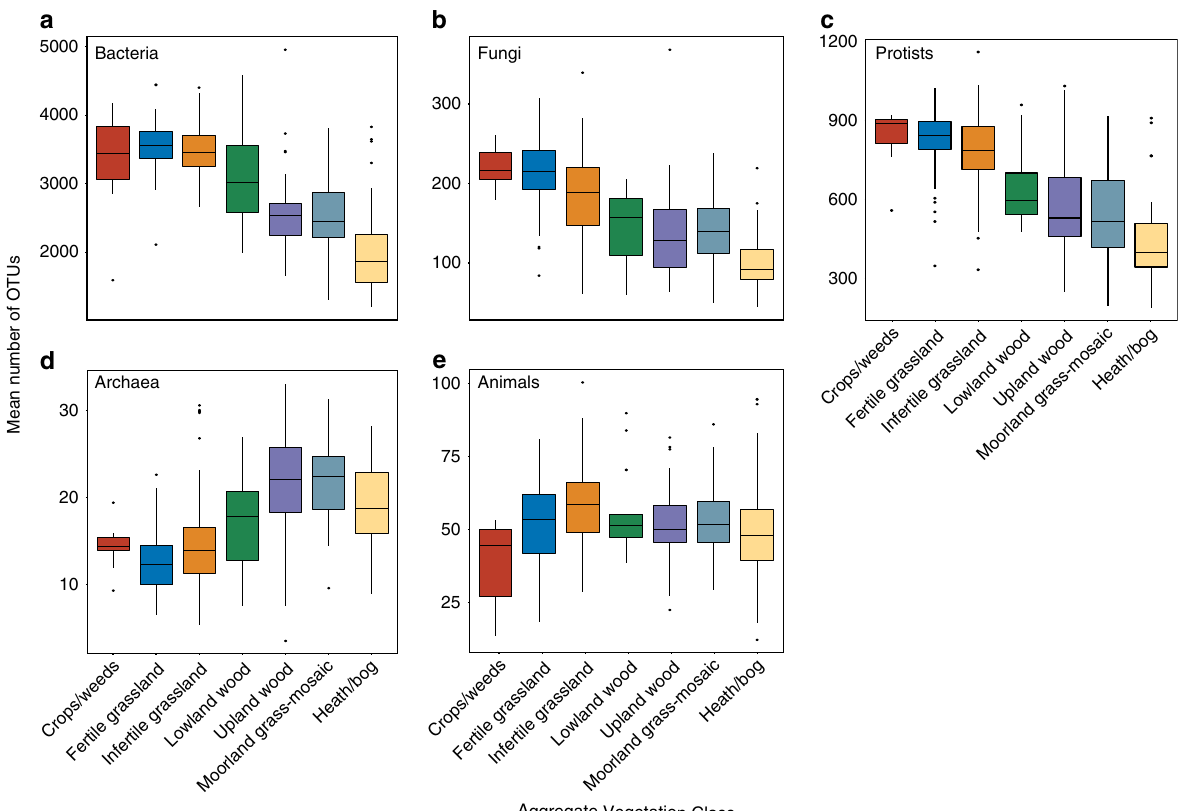
Fig. 3 Boxplots of OTU richness for each organismal group. Richness of a bacteria; b fungi; c protists; d archaea; e animals are plotted against Aggregate Vegetation Class ordered from most (crops/weeds) to least (heath/bog) productive. Boxes are bounded on the fi rst and third quartiles; horizontal lines denote medians. Black dots are outliers beyond the whiskers, which denote 1.5× the interquartile range. Source data are provided as a Source Data fi